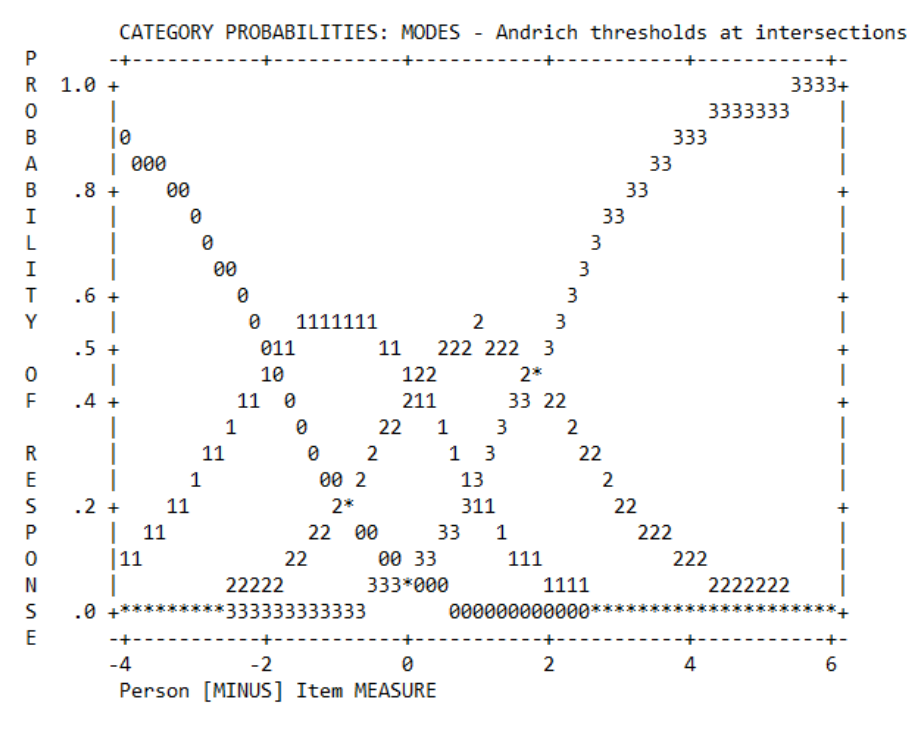
Figure 3. Probability of